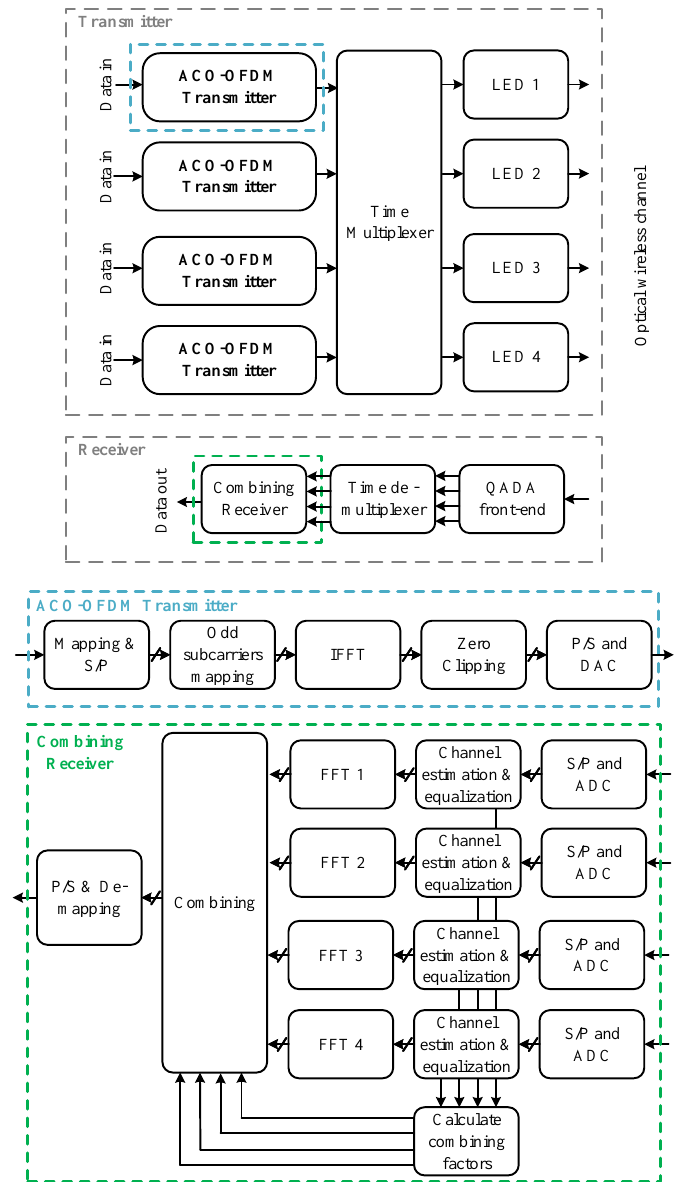
Figure 12. System block diagram of the transmitter and the QADA receiver using ACO-OFDM as the modulation in multi-luminaire scenario and using TDMA as the multiplexing